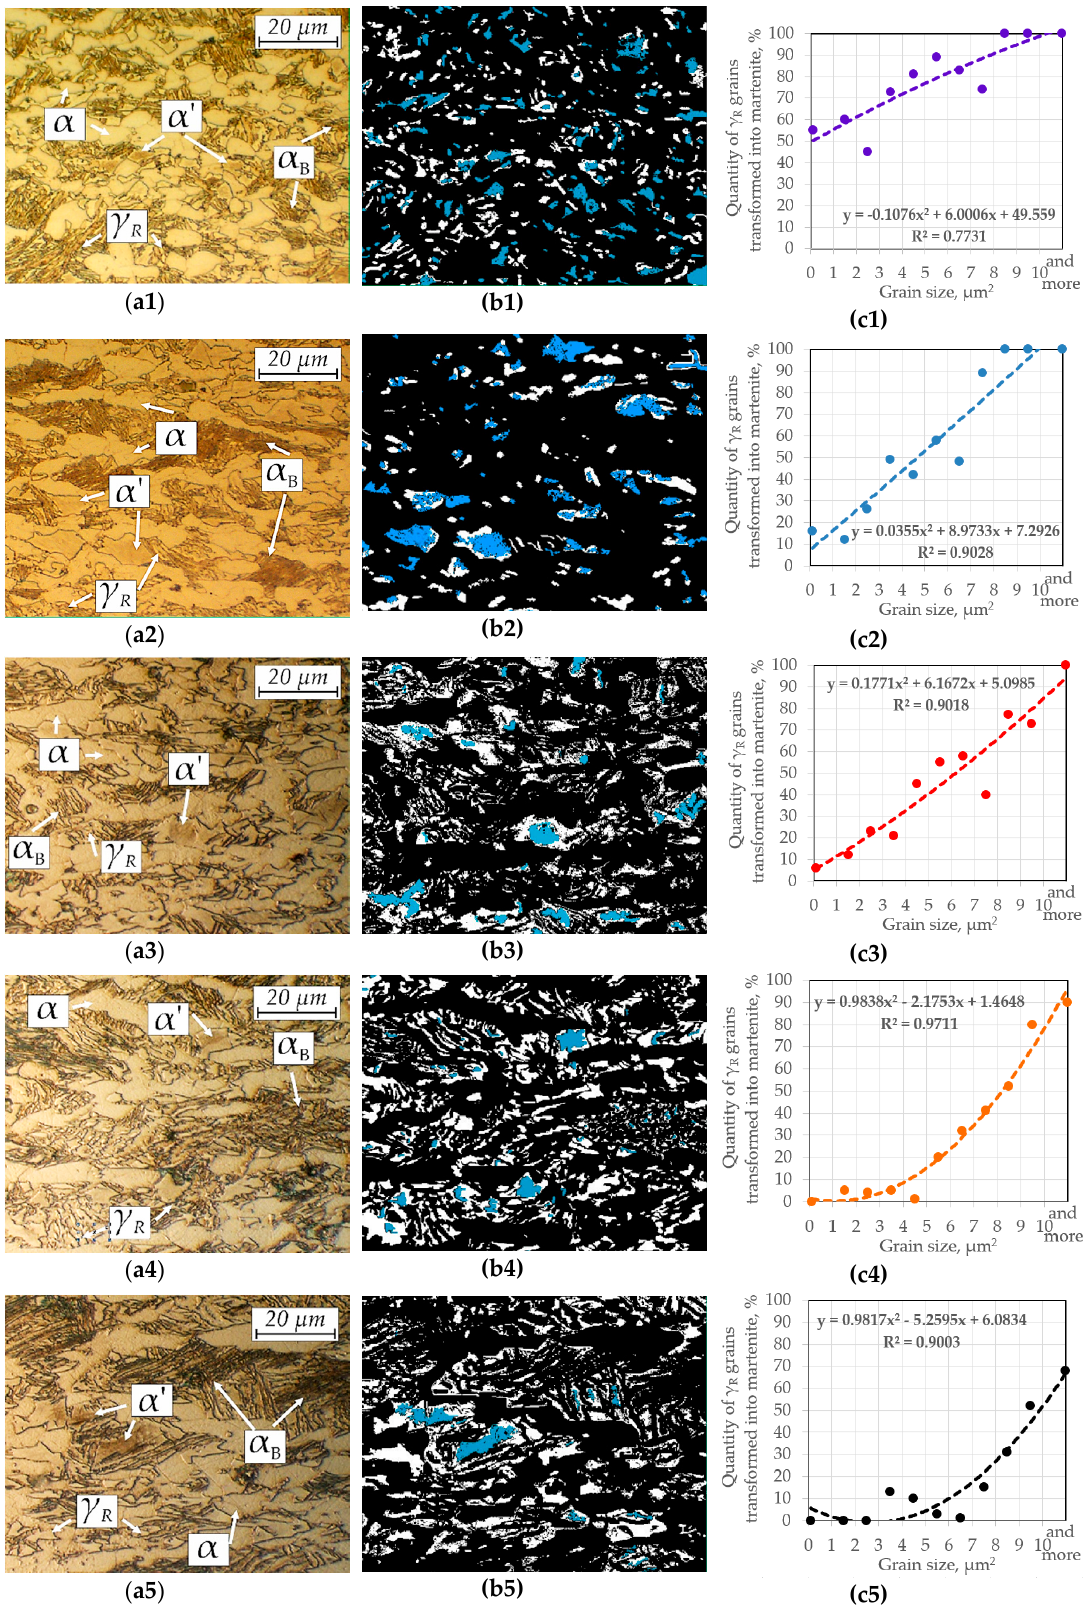
Figure 7. Results: ( a ) optical micrograph; ( b ) binary map of retained austenite (white) and martensite (blue) and ( c ) the quantity of γ that remained stable after deformation; for steel deformed at different temperatures: ( 1 ) − 20 °C; ( 2 ) 20 °C; ( 3 ) 60 °C; ( 4 ) 100 °C and ( 5 ) 140 °C.